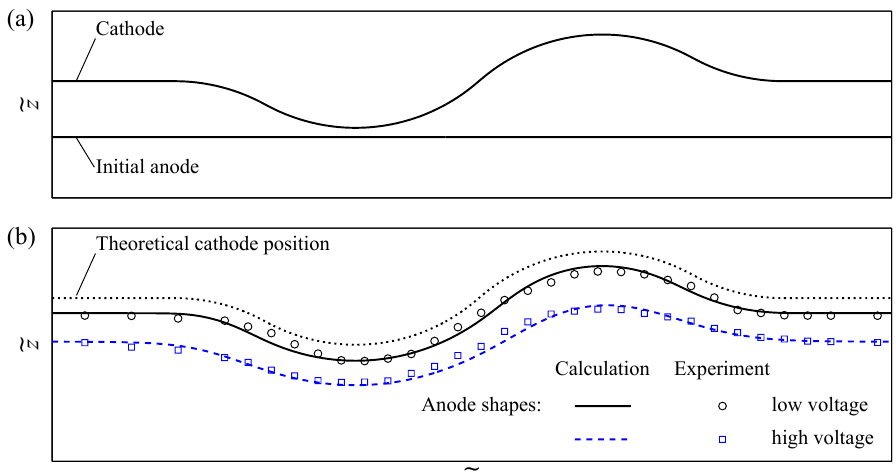
Figure A2. ECM using curved tool electrode. Panel( a ) shows the cross section of the initial configu- ration of tool and workpiece. Panel ( b ) shows workpiece surfaces after ECM two gap voltages, while the feed rate in both experiments are